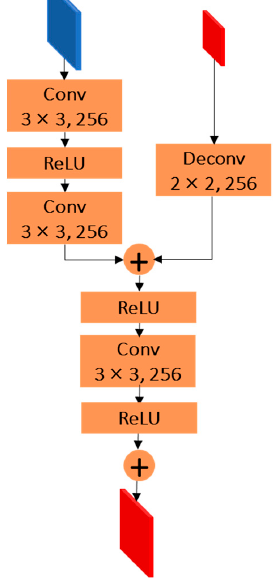
Figure 2. Skip connection block.